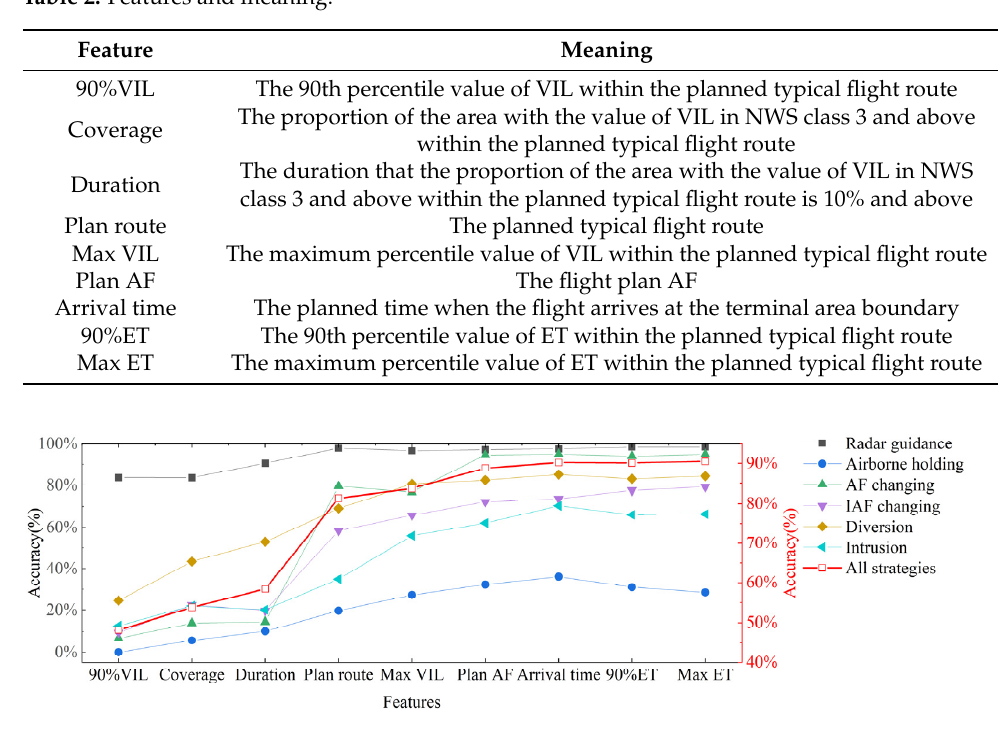
Figure 15. Prediction accuracy change caused by feature selection (ZGGG).